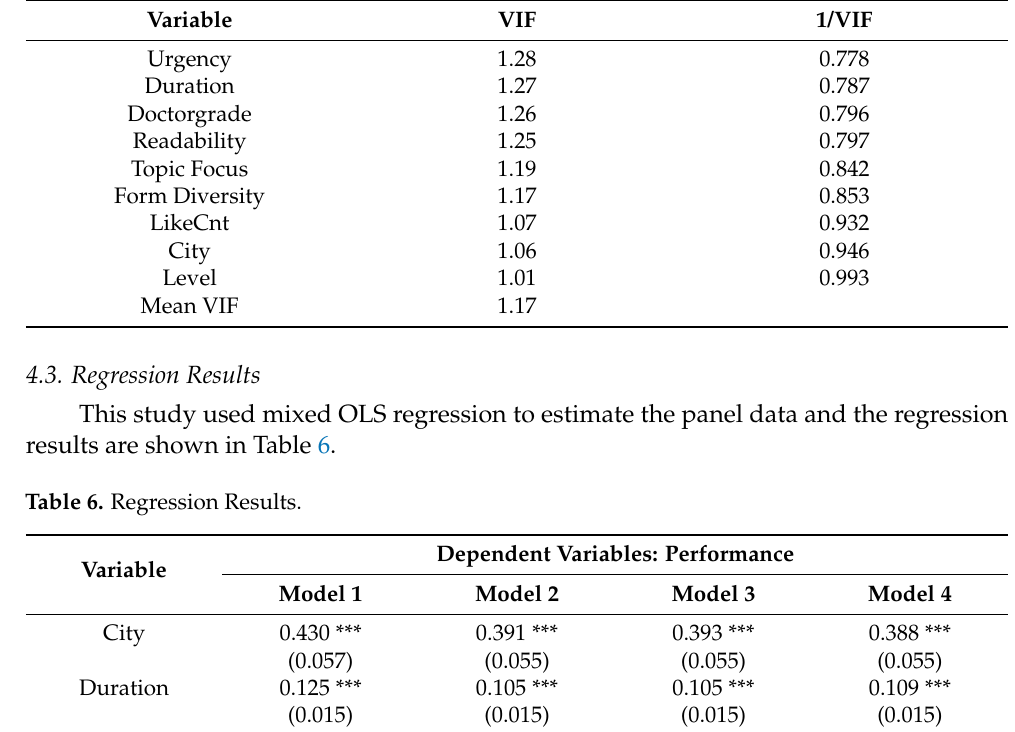
Table 5. VIF Test.